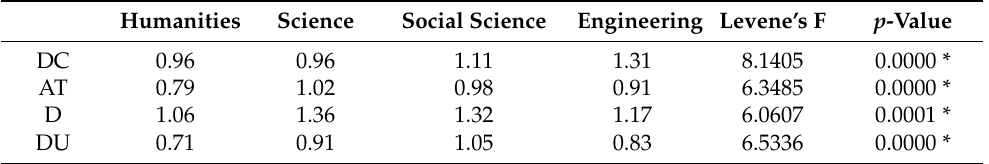
Table 9. Standard deviations (out of 5) and Levene’s test statistics when participants are differentiated by area of